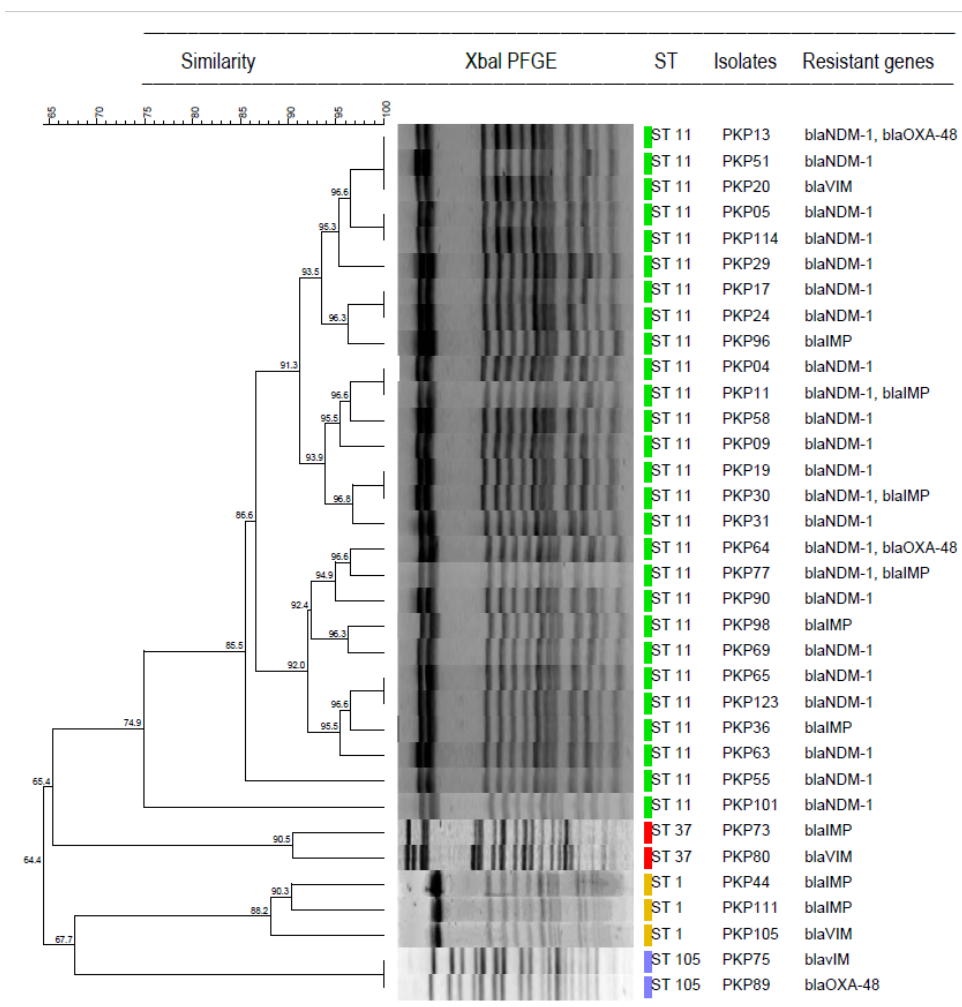
Figure 3. Xbal PFGE result of carbapenemases-producing K. pneumoniae . The cluster analysis and dendrogram is constructed by BioNumerics V 8.0. ST is short for sequence type.